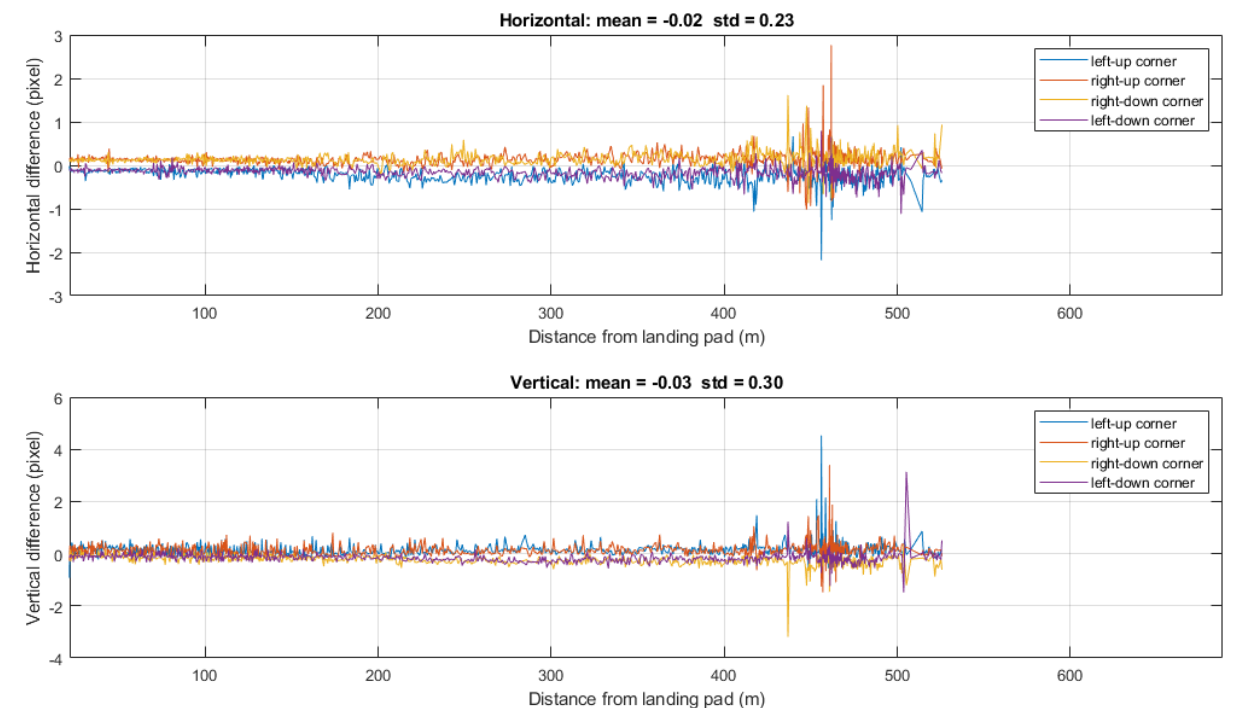
Figure 19. Difference in pixel coordinates of the 4 detected AT corners between image frames collected in the daylight and in the low − visibility test cases along a VTCA approach trajectory. Corners’ legend is referred to the biggest marker of Figure 6a.